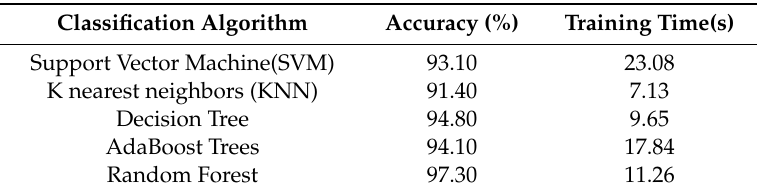
Table 2. Comparison of di ff erent classification